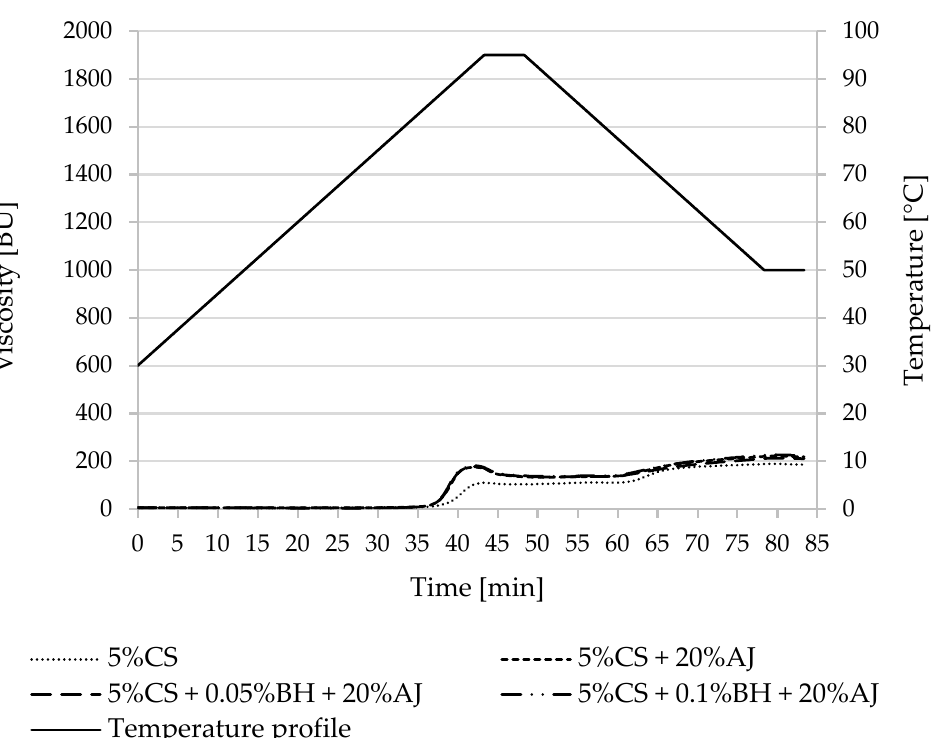
Figure 2. Pasting characteristics of 5% WPS and its mixture with apple juice and buckwheat fiber. WPS—waxy potato starch, BH—buckwheat fiber, and AJ—apple juice.